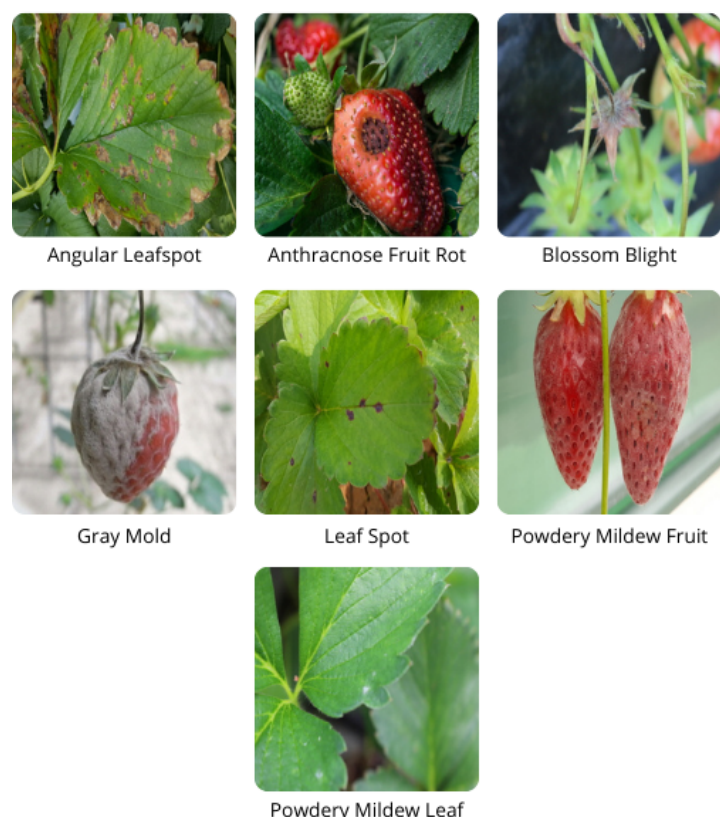
Figure 9. Samples of the diseases that the model is able to detect